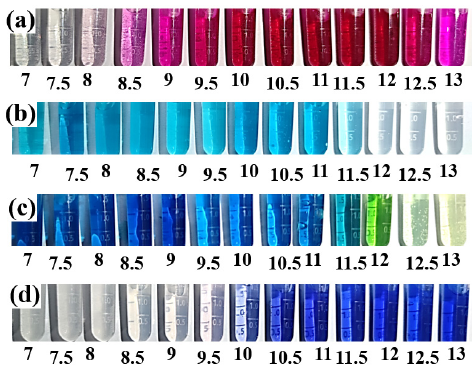
Figure 4. Discoloration behavior of ( a ) phenolphthalein, ( b ) malachite green, ( c ) indigo carmine, and ( d ) thymolphthalein exposed to varying pH. ( d ) thymolphthalein exposed to varying